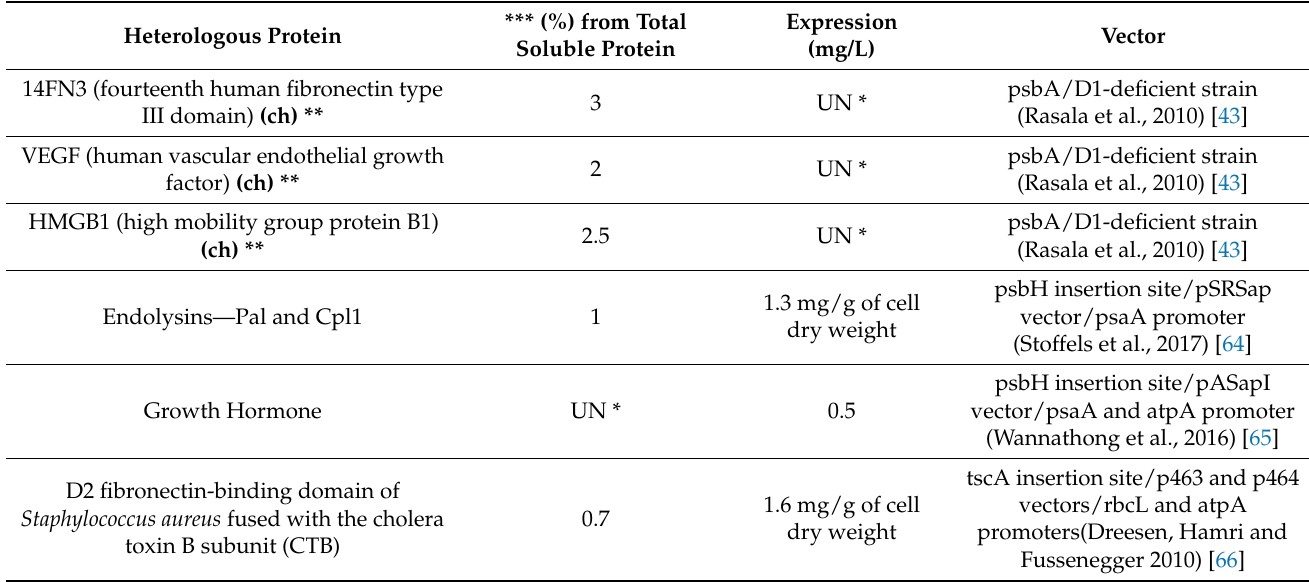
Table 1. Summary of biomolecules expressed in Chlamydomonas reinhardtii , its genetically transformed organelle, expression percentage (%) from total soluble protein, concentration in milligrams per liter (mg/L), and the cloning